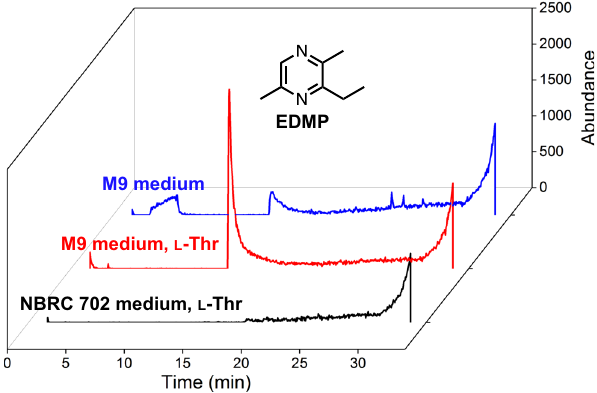
Fig. 3 EDMP production by C. necator . GC-MS chromatogram of EDMP produced by C. necator in NBRC 702 medium supplemented with L-Thr (black) or M9 minimal medium with or without L-Thr (red and blue,